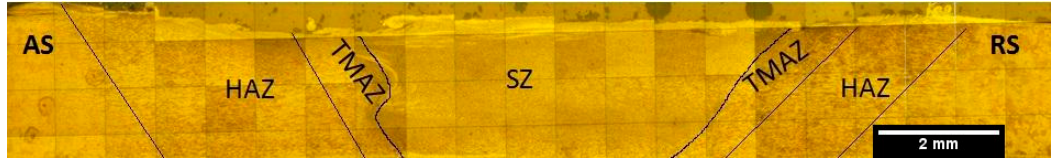
Figure 3. Friction stir welding micro-structural zones.